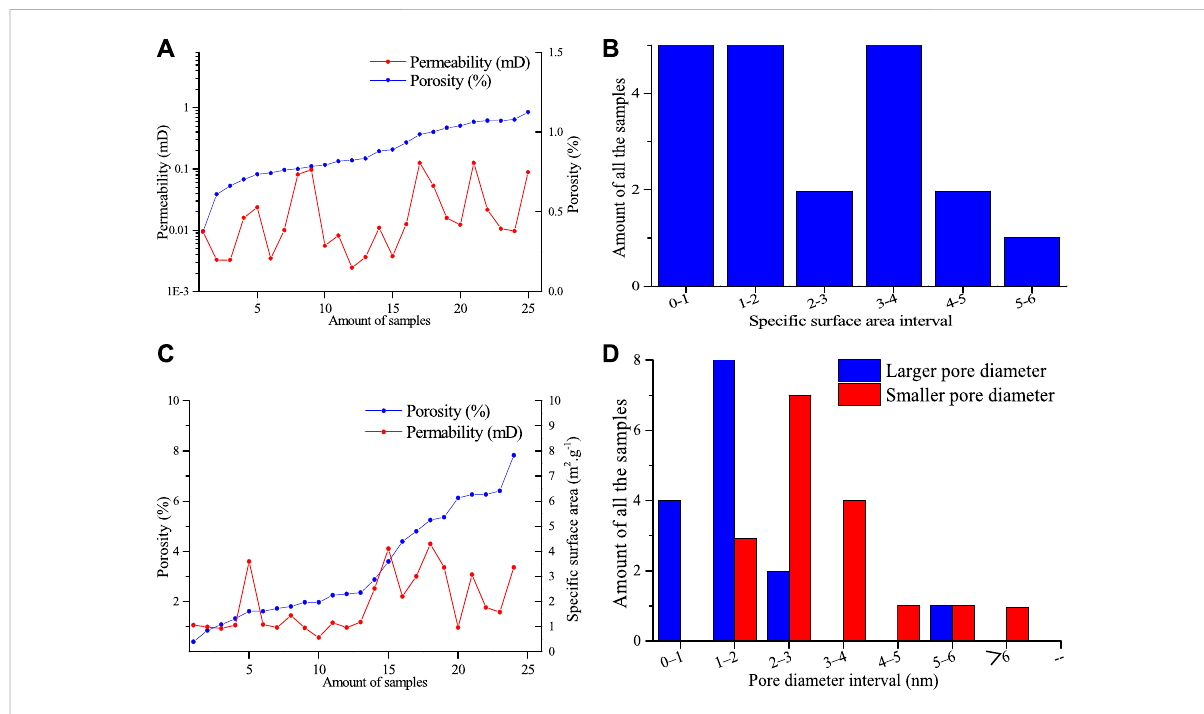
FIGURE 18 Permeability and porosity of sandstone reservoirs in the middle and lower sections/Speci fi c surface area of all the samples in middle-lower